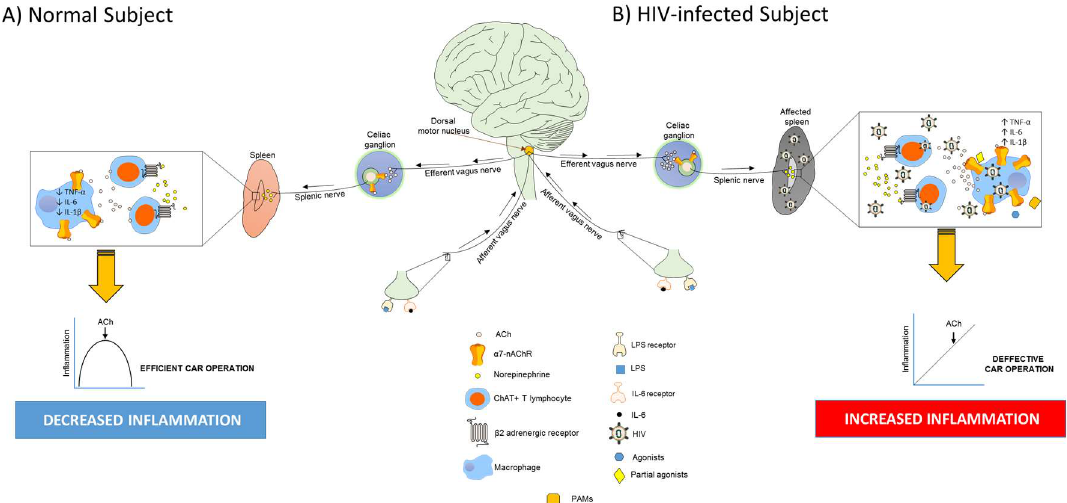
Figure 1. The cholinergic anti-inflammatory response (CAR) in normal and HIV-infected subjects. ( A ) During inflammation, the afferent vagus nerve recognizes microbial products (LPS) or cytokines (IL-6) that travel to the dorsal motor nucleus where they are interpreted and trigger an efferent response through the efferent branch of the vagus nerve. Accordingly, the efferent vagus nerve emerges from dorsal motor nucleus and innervates the celiac ganglion to release acetylcholine (ACh) that binds to α7-nAChRs in splenic neurons. Then, norepinephrine is release into the spleen via splenic nerve to activate β2-adrenergic receptors ChAT + T lymphocytes which, in turn, secrete ACh that activates macrophage’s α7-nAChR, inhibiting the release of proinflammatory cytokines (i.e., TNF-α, IL-6, and IL-1β); ( B ) In HIV-infected subjects, the spleen and the CAR seem to be compromised and persistent inflammation is maintained. In fact, there is evidence demonstrating that addition of ACh does not decrease the production of proinflammatory cytokines in monocyte-derived macrophages despite elevated levels of α7-nAChR, suggesting a CAR disruption [107]. On the other hand, the α7-nAChR in macrophages could be exploited as a pharmacological option to treat inflammation by means of agonists, partial agonists, or positive allosteric modulators (PAMs).